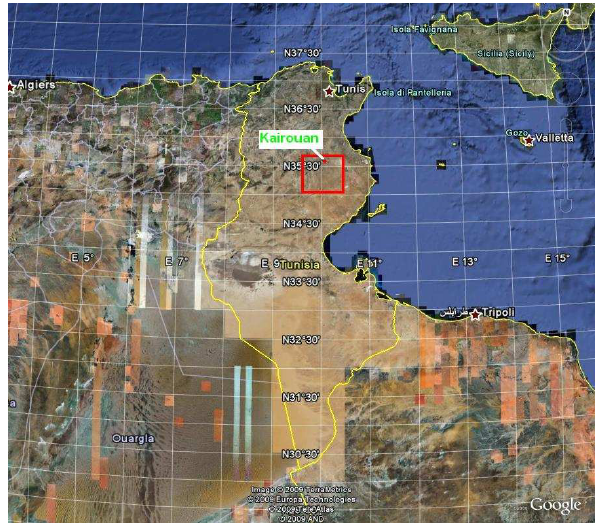
Fig. 1. Illustration of the studied